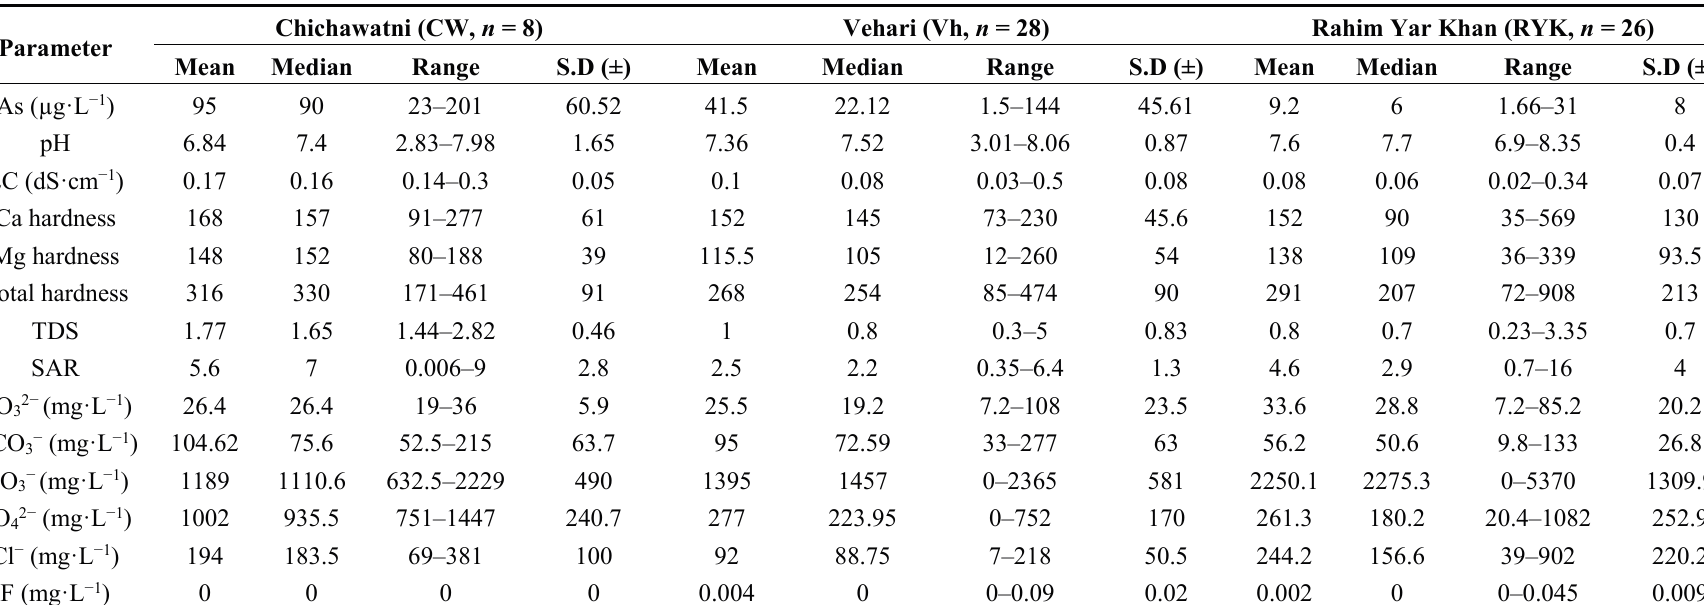
Table 1. Summary statistics of anions and hydrochemical water quality parameters in groundwater samples collected from three rural areas of Punjab,